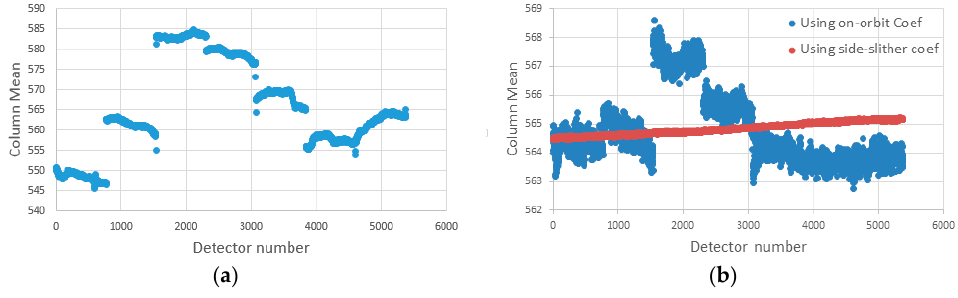
Figure 8. Column mean value analysis of the standard image and corrected images. ( a ) The column means of the standard image; ( b ) The column means of images corrected using the on-orbit coefficients and the side-slither coefficients.